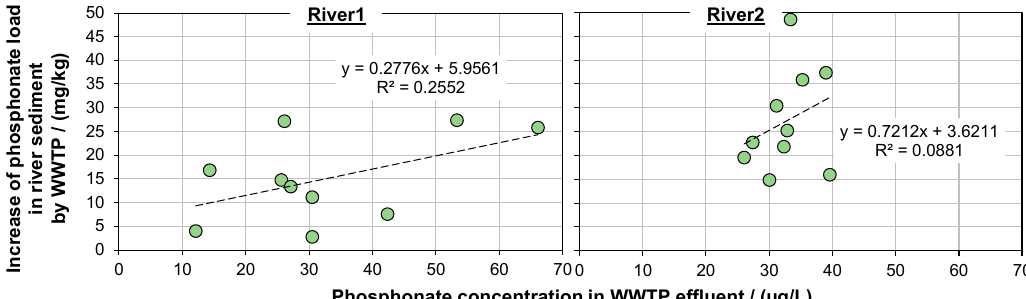
Figure 6. Increase of the sediment phosphonate loads (load behind minus load before the WWD) in both rivers as a function of the dissolved phosphonate concentrations in the WWTP effluents (WWTP data from Rott et al. [12]).